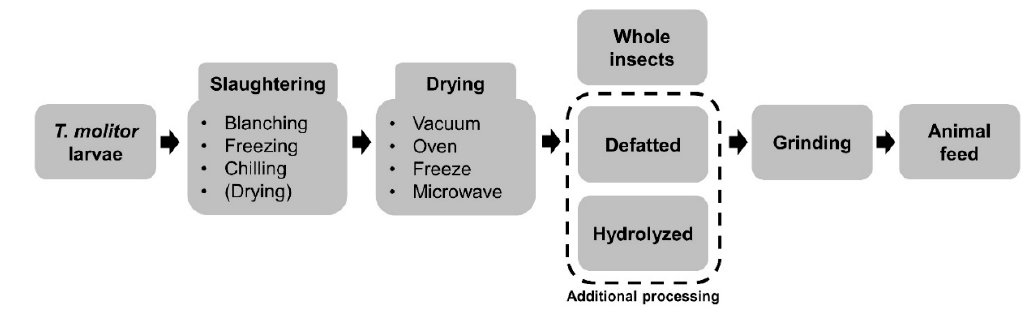
Figure 1. Scheme of Tenebrio molitor larvae processing for animal feed.